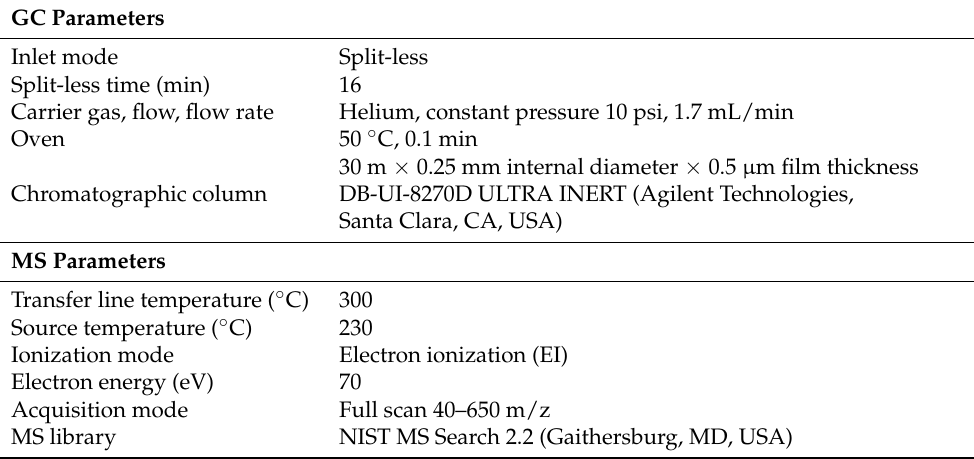
Table 9. GC/MS parameters for the determination of SVOCs in Gelam